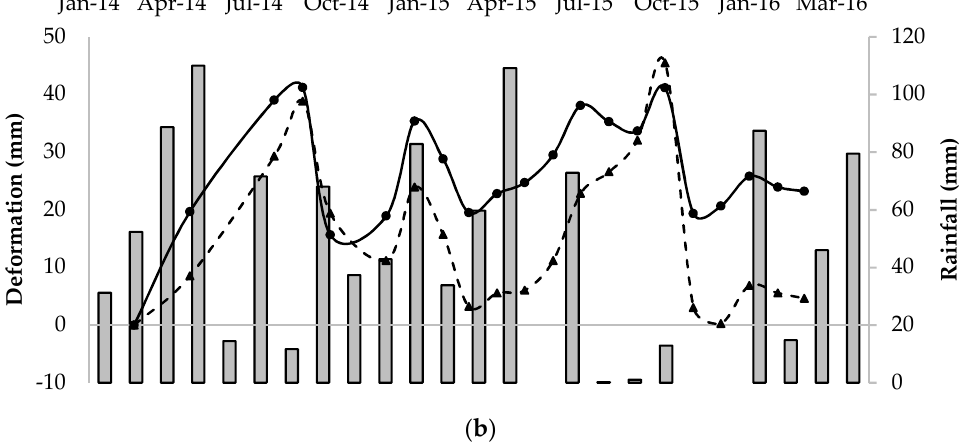
Figure 10. Deformation variation of edge and center with rainfall events at ( a ) FM 2757 and ( b ) SH 342 site.